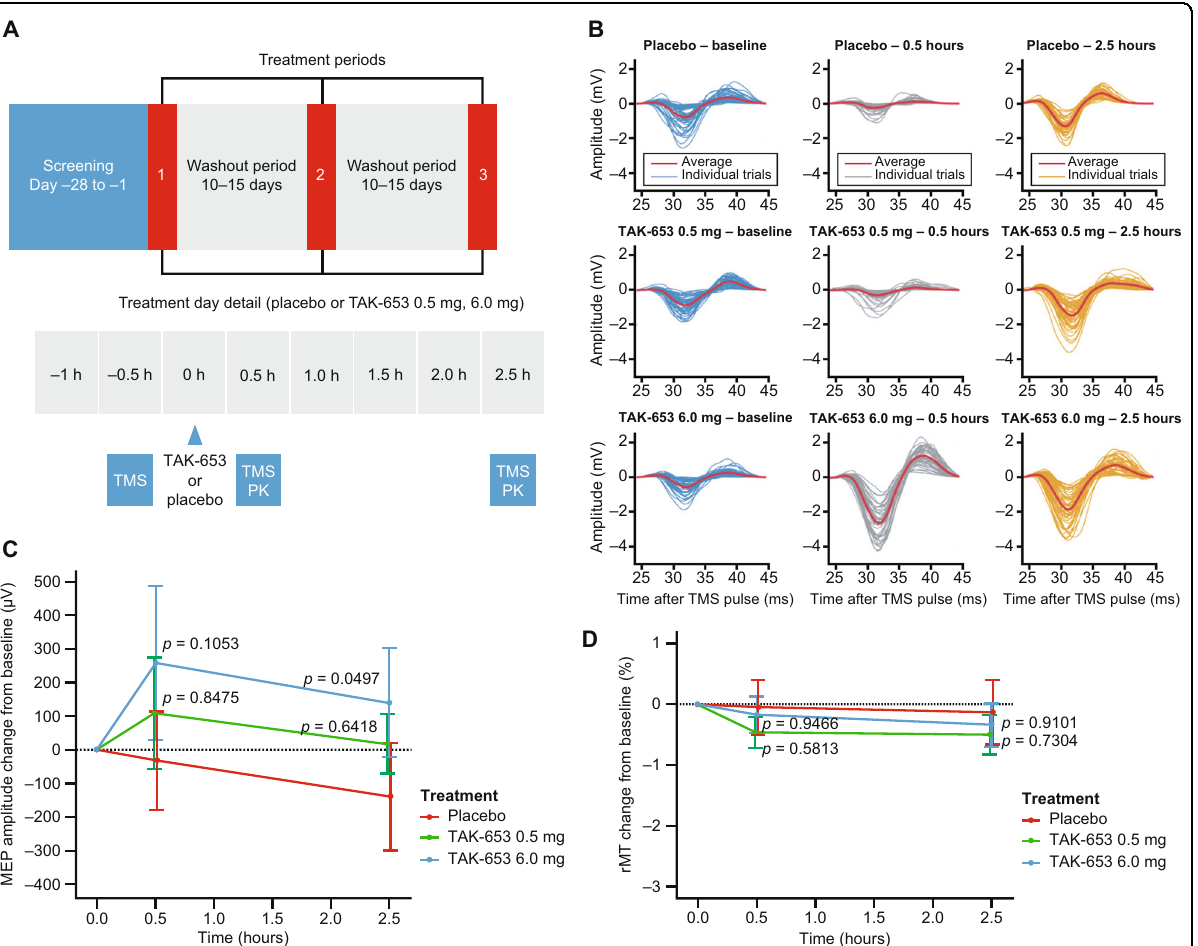
Fig. 2 6 mg TAK-653 enhanced MEPs in healthy volunteers. A Study schematic (top) and detail of treatment day events (bottom). B representative MEP waveforms from one participant at baseline, 30 min, and 2.5 h post-dose for all three treatment periods. C Changes from baseline in MEP amplitude for placebo, 0.5 mg TAK-653, and 6 mg TAK-653 periods. p = Dunnett adjusted p value. D Changes from baseline in rMT for all three periods. MEP, motor-evoked potentials; PK, pharmacokinetic; rMT, resting motor threshold; TMS, transcranial magnetic